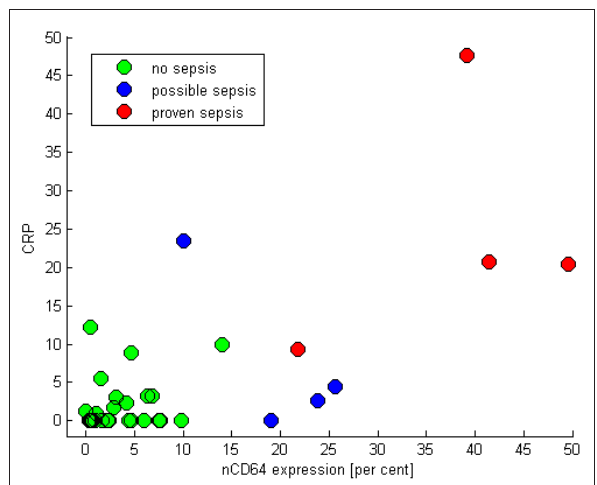
Fig. 4. Comparing markers (CRP [mg/L] and nCD64) and their yields in the diagnosis of LOS. Expression of nCD64 (ver- tical distribution) is clearly better at stratifying patients than CRP (horizontal distribution).